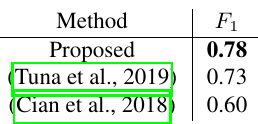
Table 2. Quantitative evaluation of flood detection results for different methods using the F 1 measure.